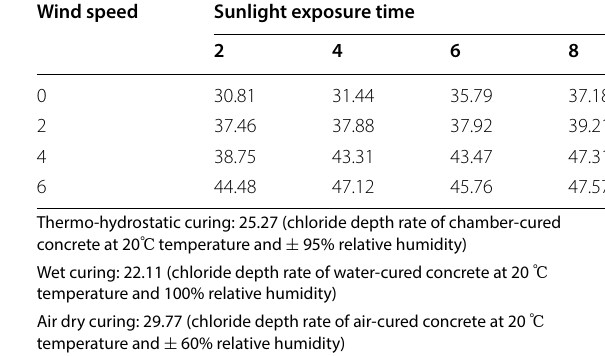
Table 5 Test results of concrete chloride depth rate